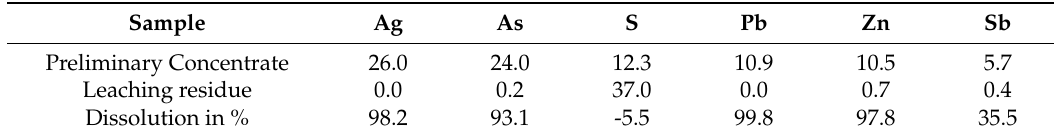
Table 7. Composition (wt. %) of reference trial leaching